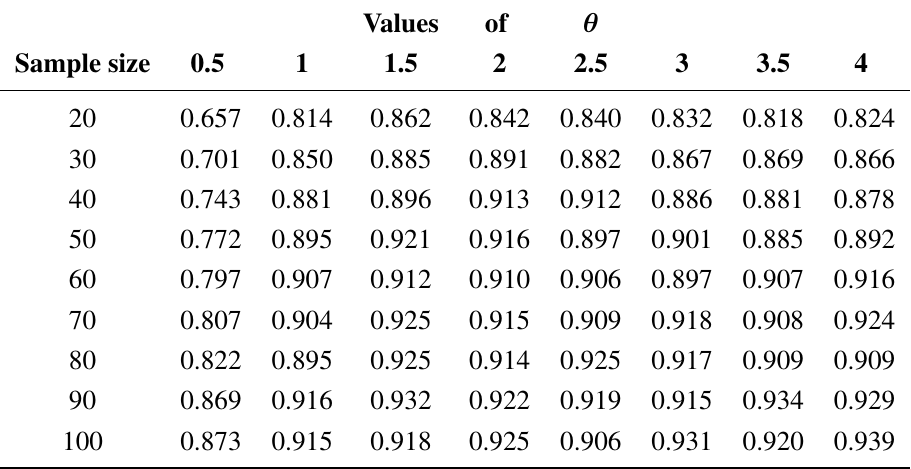
Table 4. Estimated coverage probability of the bootstrap 95% confidence intervals for the variance parameter, σ 2 , using the percentile method.